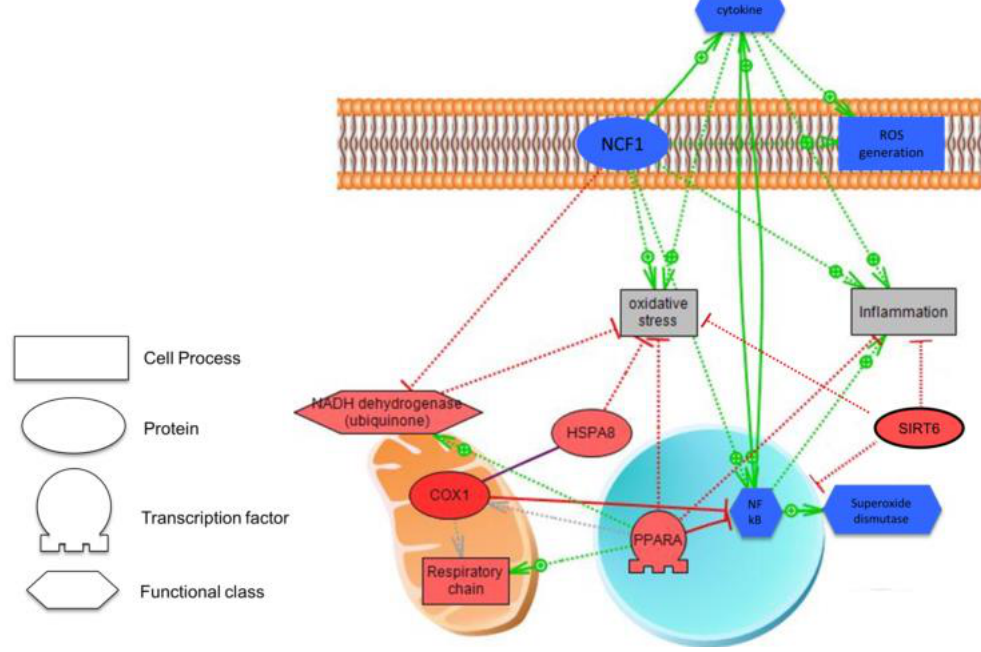
Figure 4. Model describing changes in gene expression profile observed in exfoliated epithelial intestinal cells (EEIC). Up-regulated (in red) and down-regulated (in blue) genes in preterm infants fed OMM vs. DHM. The solid line means expression and dashed line means regulation. Relations are colored by effect: Red expresses a negative effect, and green represents a positive effect. Grey means we can observe the unknown effect.